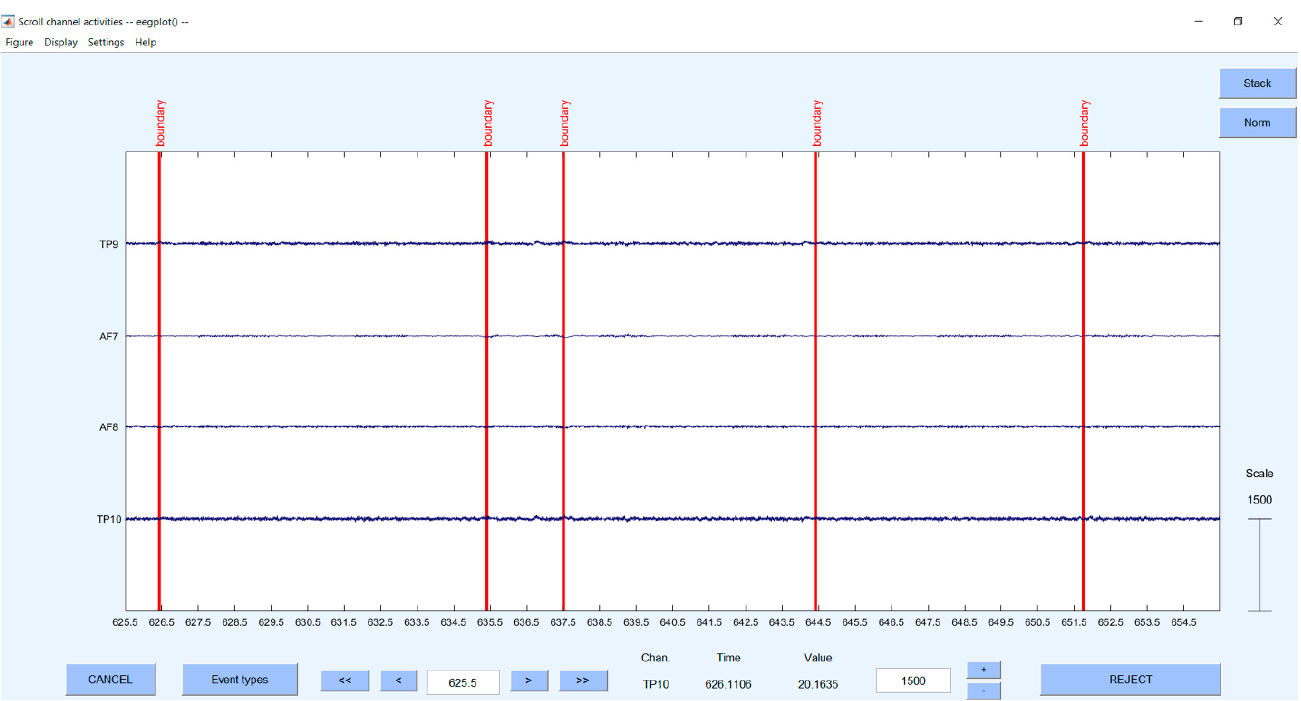
Figure A1. The raw EEG signal of Participant 1 after artifact removal using a sliding window size of 30 seconds. The green-highlighted boundaries indicate spikes caused by artifacts such as eye blinking. The hyphen (-) in the figure serves as a representation of the minus sign ( − ) in EEGLab.